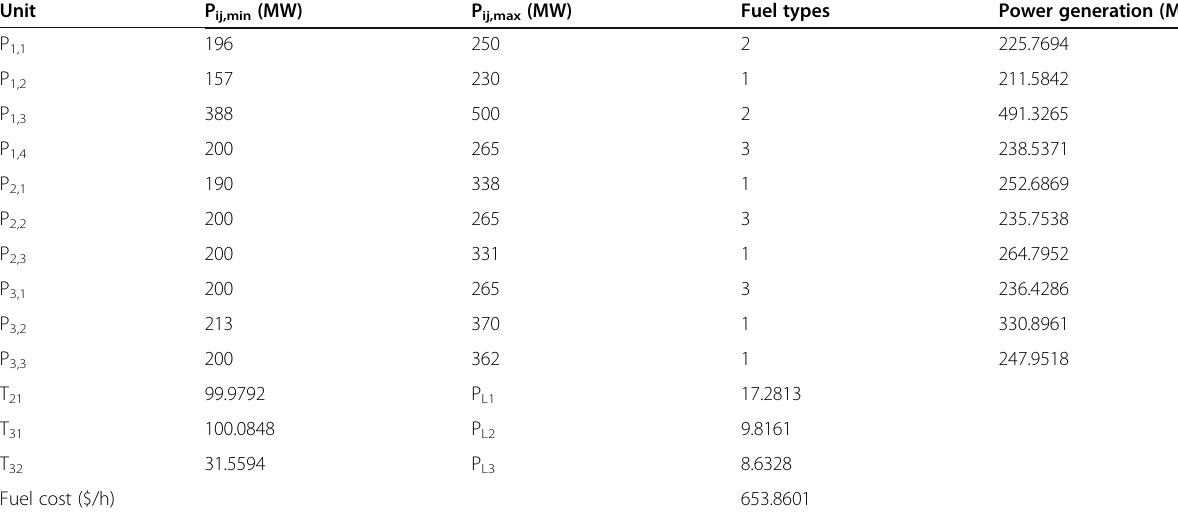
Table 6 Best dispatch solution incurred by the proposed SSA algorithm for MAMFED problem Unit